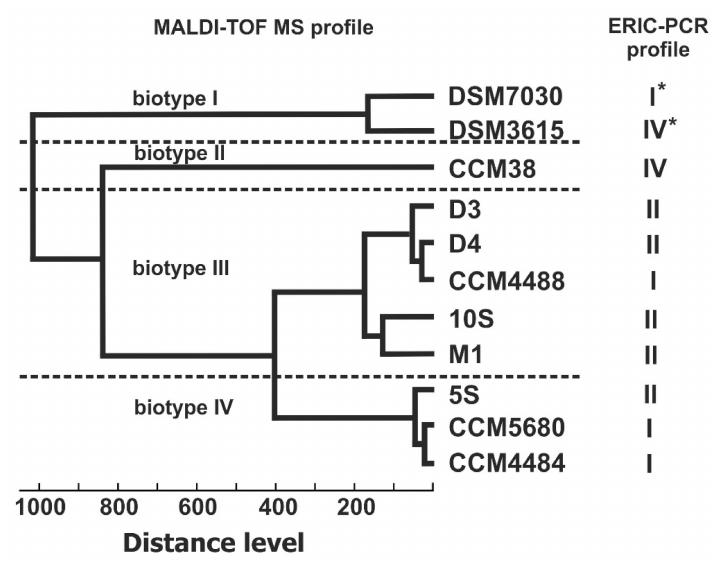
Figure 3. Similarity dendrogram of P. larvae isolates based on comparison of MALDI-TOF protein spectra. For DSM7030 and DSM3615, genotype data obtained from the literature [8] and the main spectra profile included in the Bruker database (version 3.3.1.0) were used (marked by